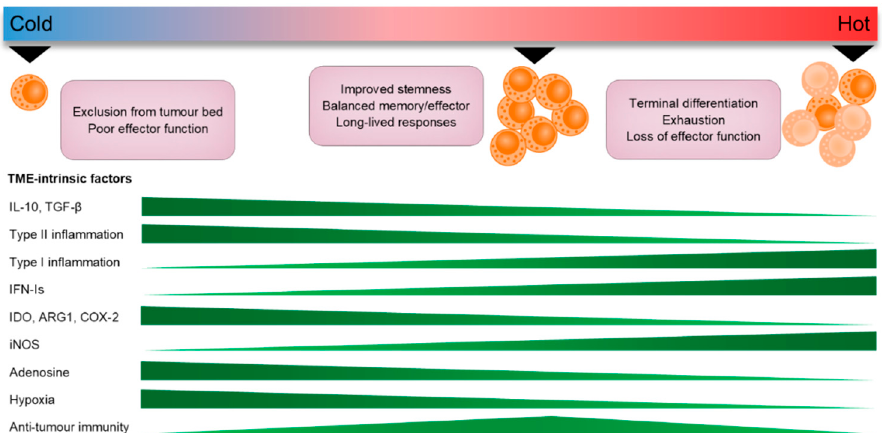
Figure 3. Tumours with intense inflammation may perturb the homeostatic balance of memory- effector T cell populations in the TME. ‘Cold’ tumour niches contain an abundance of canonical immunosuppressive factors that create an immune-privileged TME. Conversely, ‘hot’ tumours that contain excessive amounts of pro-inflammatory factors may disrupt the balance of effector-memory CTL populations, resulting in short-lived effector responses. In contrast, a balance of pro- and anti-inflammatory signals in the TME may endow CTLs with improved cytolytic responses that are long lived.